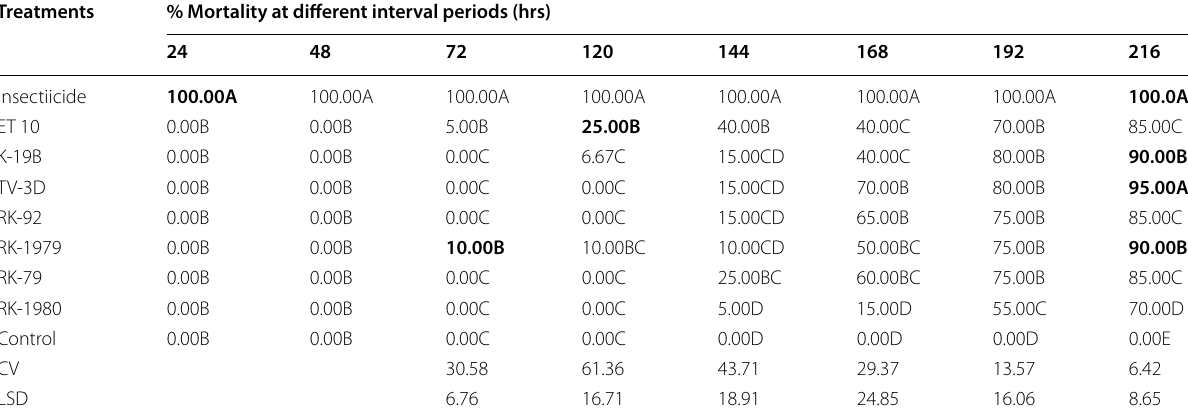
The highest measurement values obtained according to the observation time are highlighted in bold